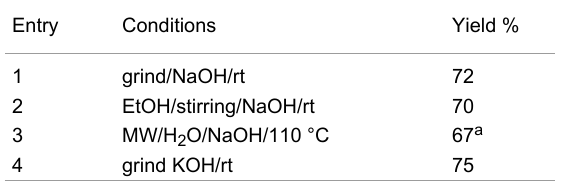
Table 1: Synthesis of the 1-azulenyl-2’-azachalcone 2a